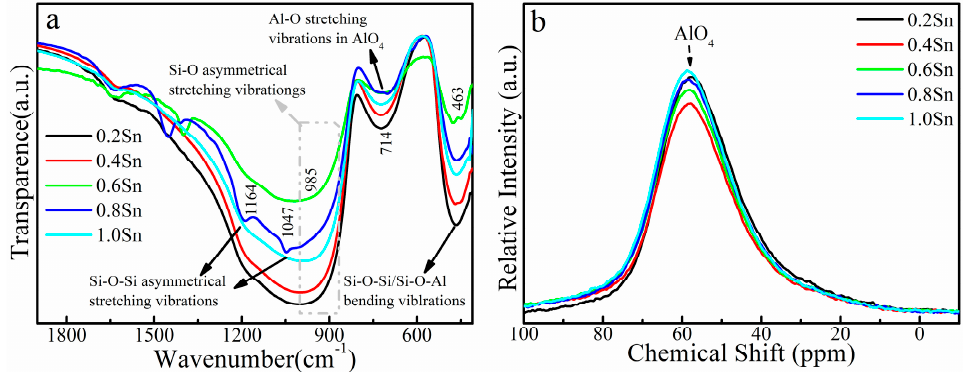
Figure 4. ( a ) FTIR spectra of 59.5SiO 2 -10Al 2 O 3 -30CaO-0.5Bi 2 O 3 -xSnO 2 glass samples. ( b ) 27 Al NMR spectra of (59.5-x) SiO 2 -10Al 2 O 3 -30CaO-0.5Bi 2 O 3 -xSnO 2 glass samples.